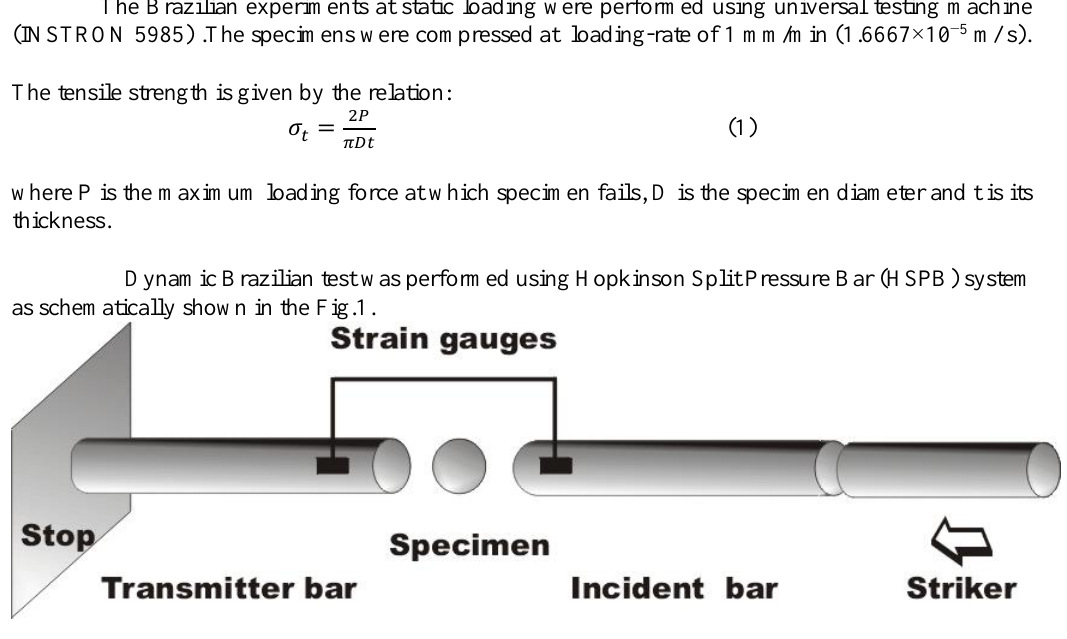
Fig.1. Schematic of the dynamic Brazilian